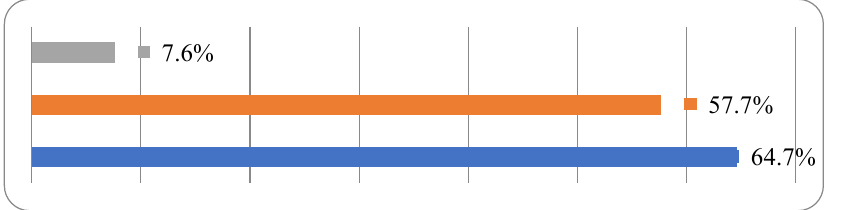
Figure 1. Distribution of willingness to participate in voluntary disaster preparedness activities. Note: Gray bar stands for emergency information report. Orange bar stands for drill organizing activities. Blue bar stands for disaster knowledge and skill training activities.